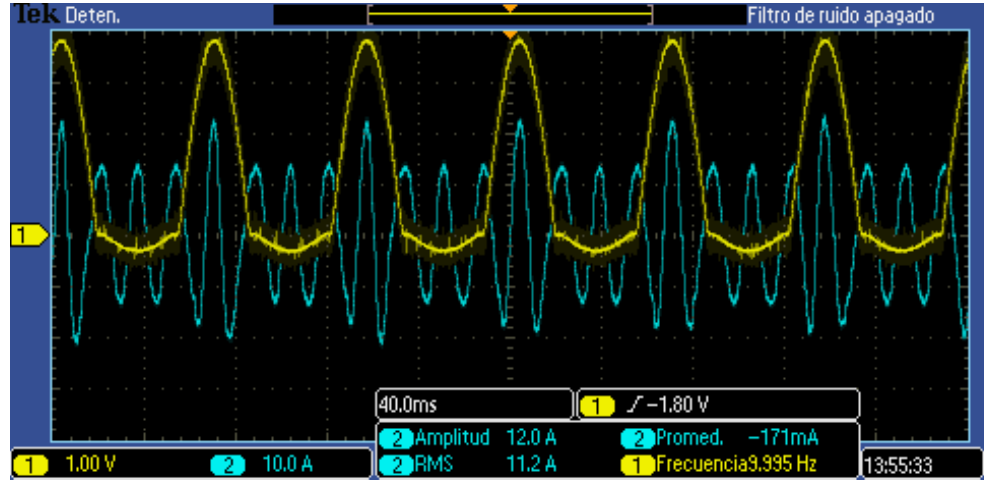
Figure 21. Motor current under control. Reference signal frequency: 10 Hz.